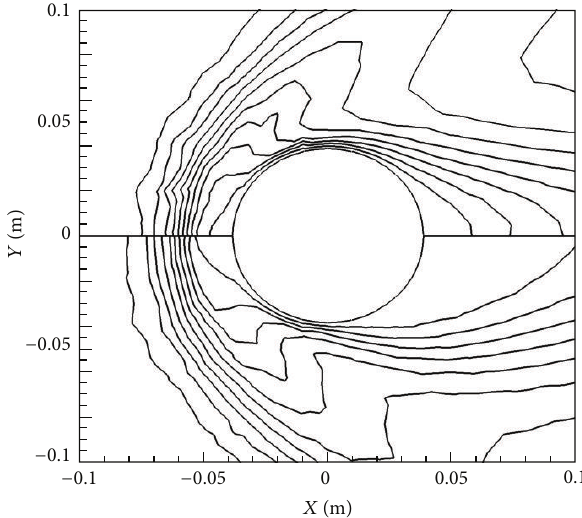
Figure 7: Comparison of 𝑈 velocity contours without magnetic field (top) and with 𝐵 max = 2 T oriented in 𝑋 -direction (bottom).